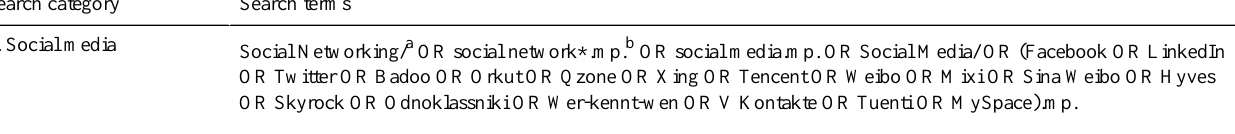
Search termsSearch